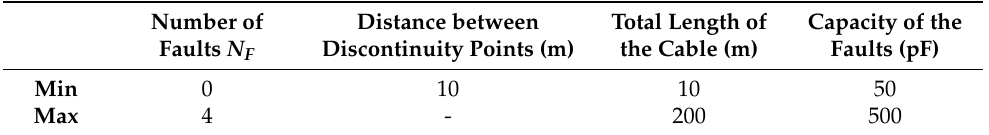
Table 2. Parameters of the simulated transmission